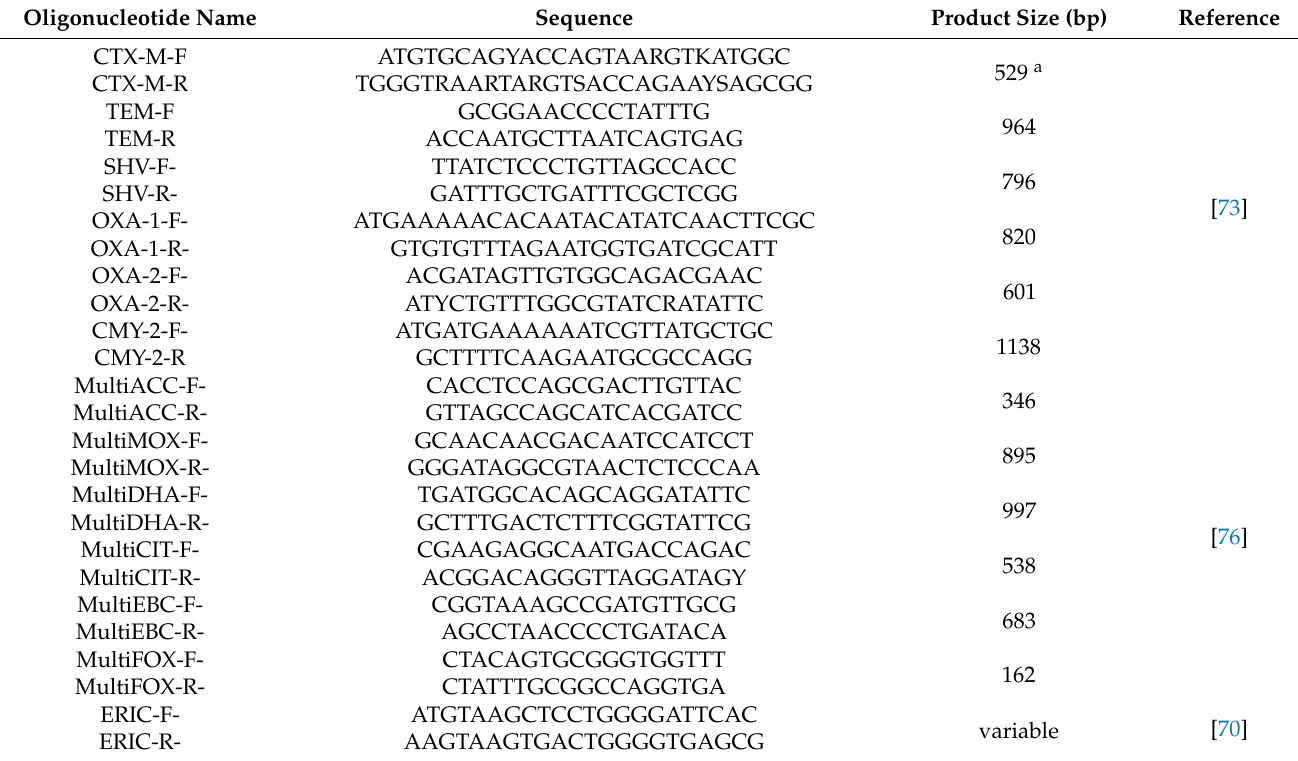
Table 3. PCR primers used for detection of beta-lactamase genes and ERIC-PCR